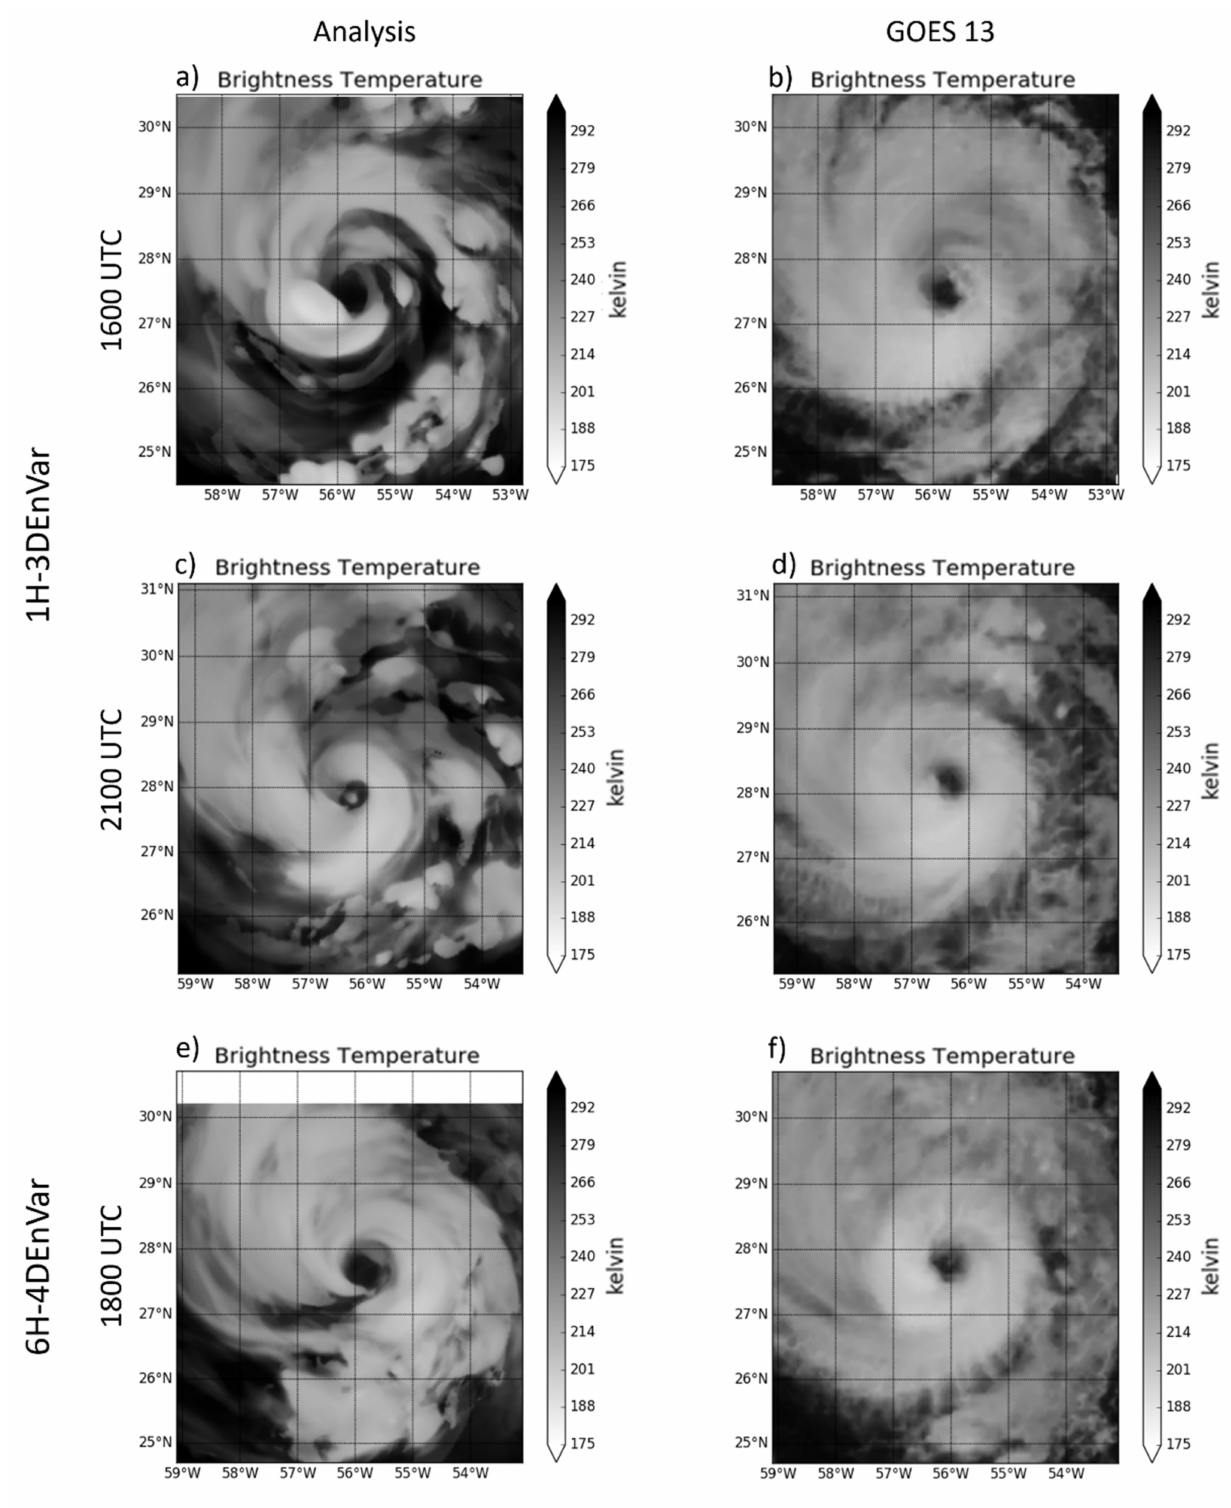
Figure 11. Simulated brightness temperature from the E2 1H-3DEnVar analysis in ( a , c ) at 1600 UTC and 2100 UTC, respectively, and ( e ) 6H-4DEnVar analysis at 1800 UTC. Observed GOES 13 LWIR in ( b , d , f ) at 1600 UTC, 2100 UTC, and 1800 UTC 15 September 2014,